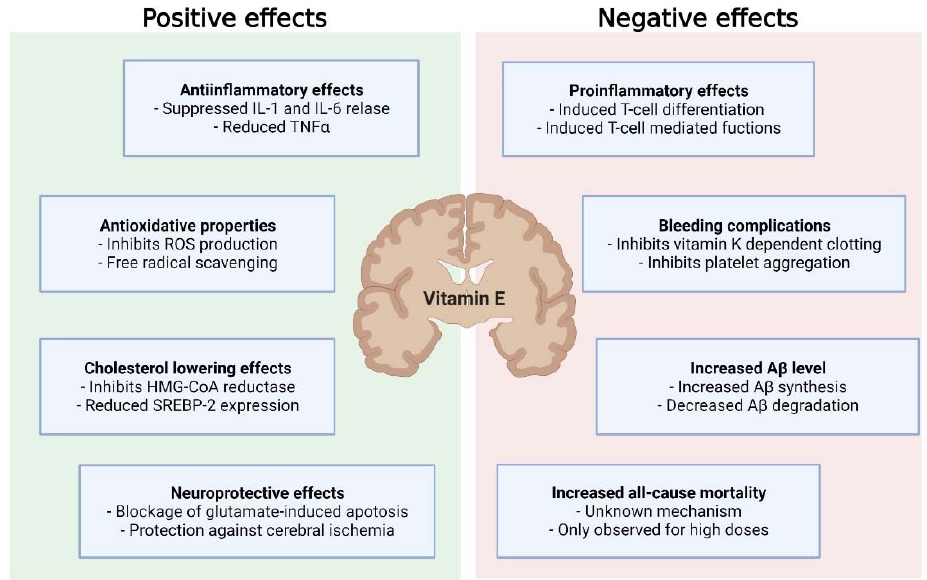
Figure 2. Positive and negative effects of vitamin E supplementation on neurodegenerative diseases.